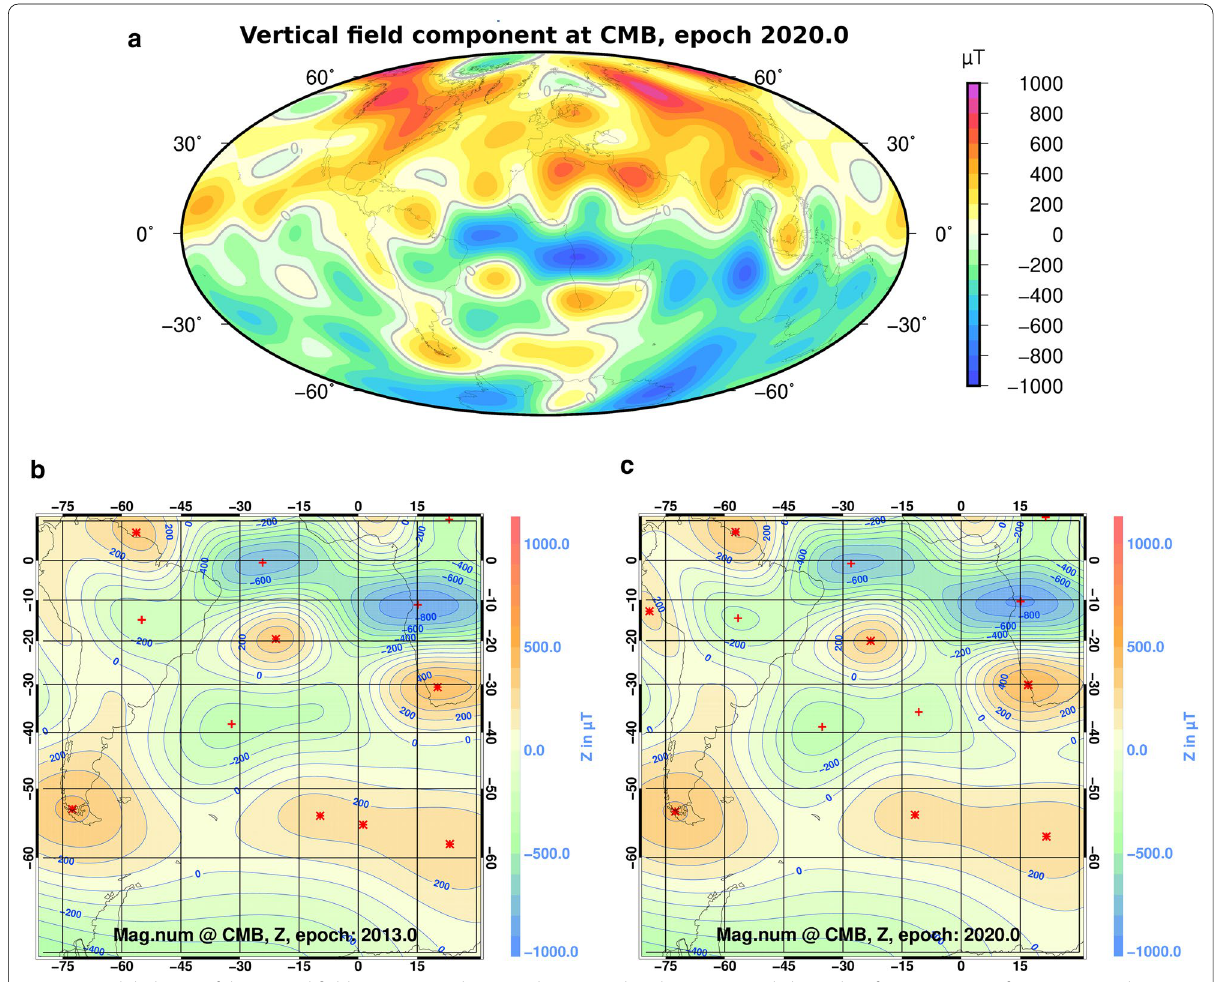
Fig. 10 a Global map of the vertical field component downward continued to the core–mantle boundary from Mag.num for 2020.0. Local extrema of normal (red plusses) and reverse (red stars) flux are marked in the more detailed regional maps for 2013.0 ( b ) and 2020.0 ( c